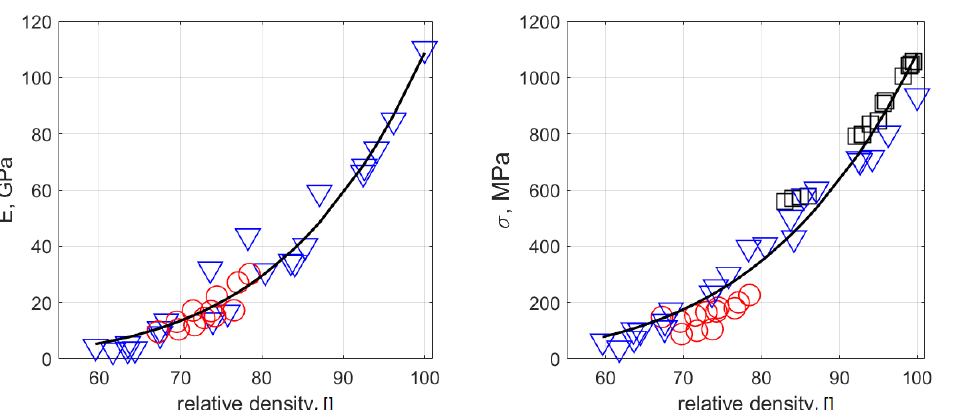
Figure 12. Mechanical properties of the sintered samples as a function of the relative density. The ( left ) panel shows experimentally obtained data for Young’s modulus [6,69] and the ( right ) panel shows the experimental data for yield stress [6,68,69] as a function of the relative density in each case. The following symbols are used in the left panel (cid:13) represent results from [68] and (cid:53) corresponds to [6]; while in the right panel (cid:53) —[6], (cid:13) —[69], (cid:3) —[68]. The solid lines represent the results of fitting by correlations (18).